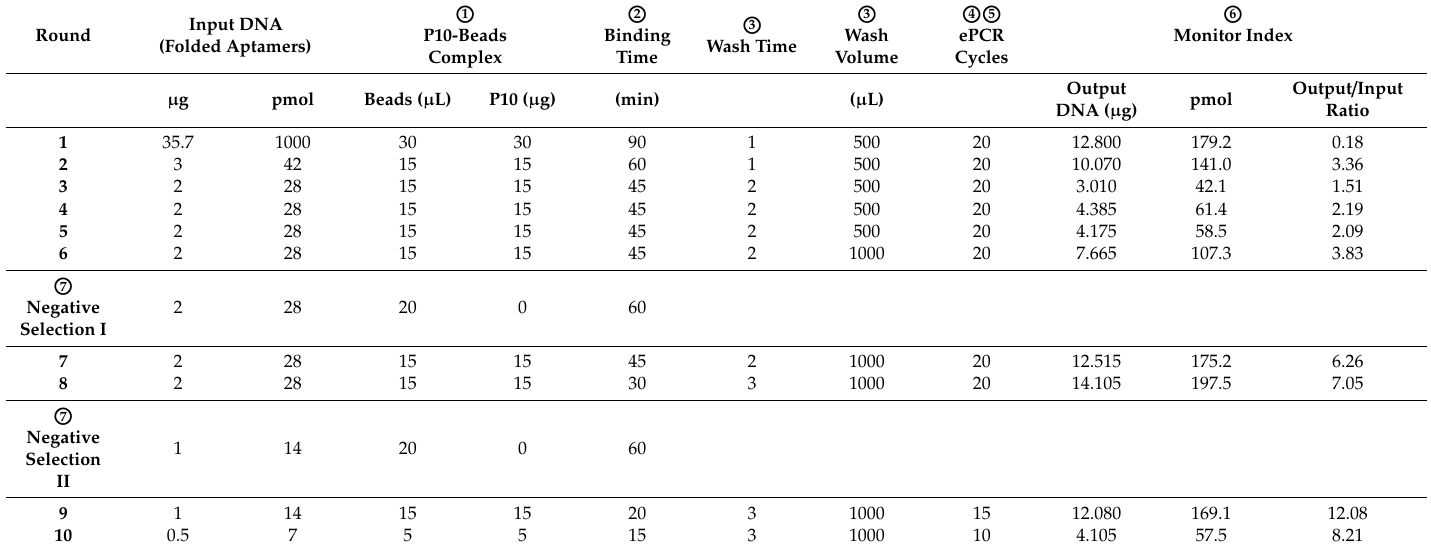
Table 1. Changes of parameters in screening aptamers against RBSDV His-P10 protein by SELEX from rounds 1 to